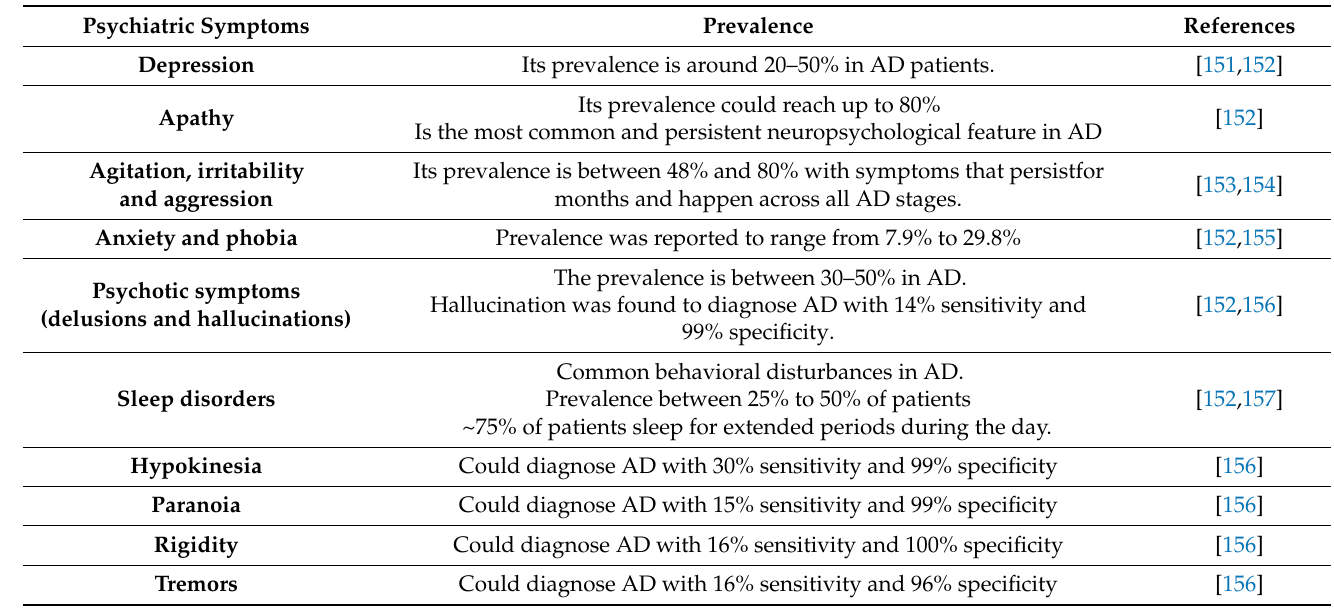
Table 2. Psychiatric symptoms of